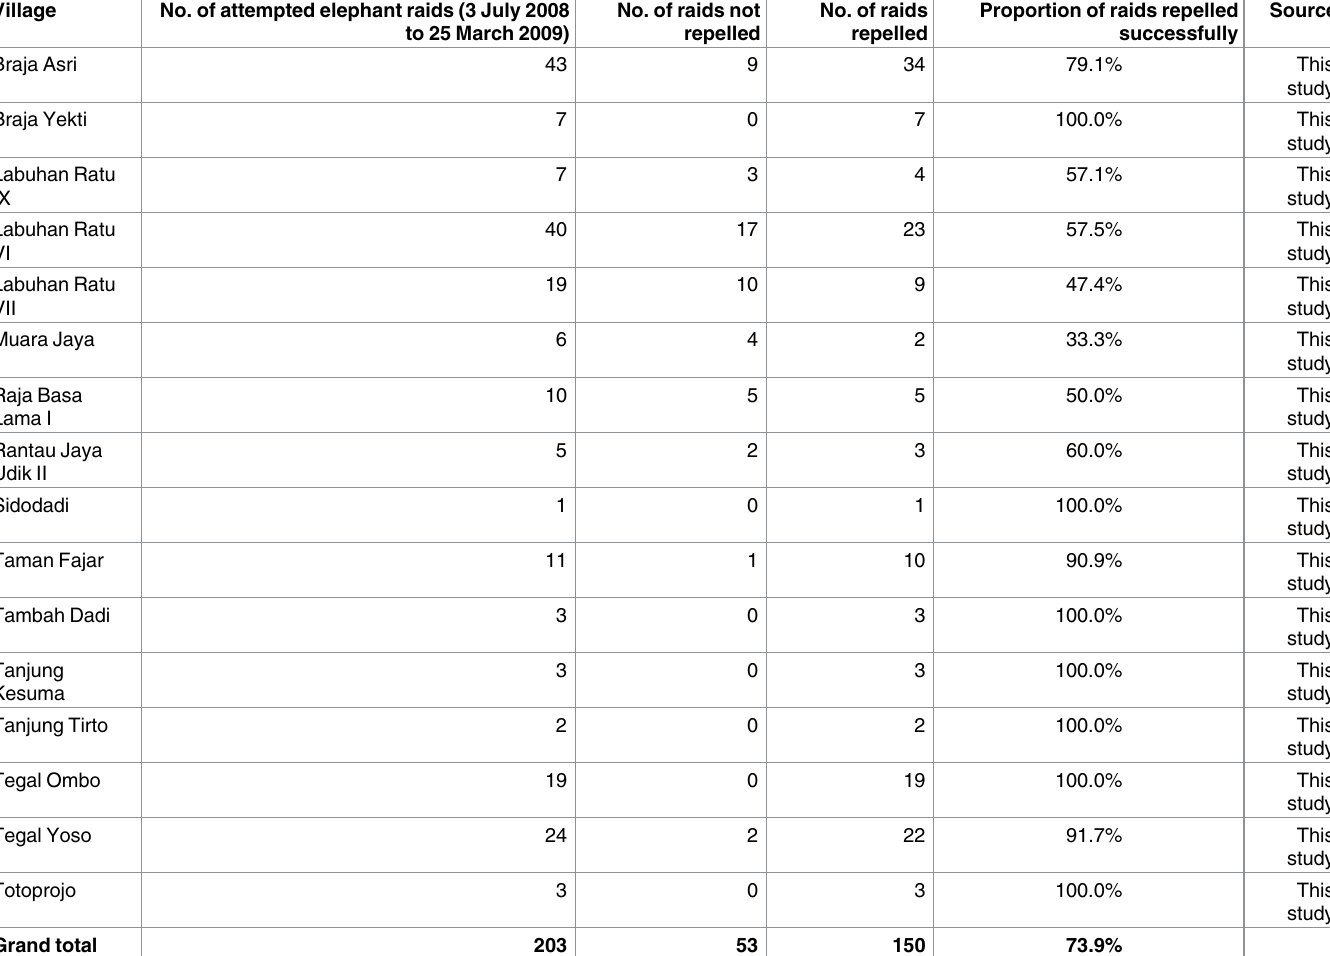
Table 5. Proportion of attempted elephant raids repelled by villagers using voluntary community-based crop protection methods (‘conventional’ methods) for 16 villages in Phase 3. Village No. of attempted elephant raids (3 July 2008 to 25 March 2009)